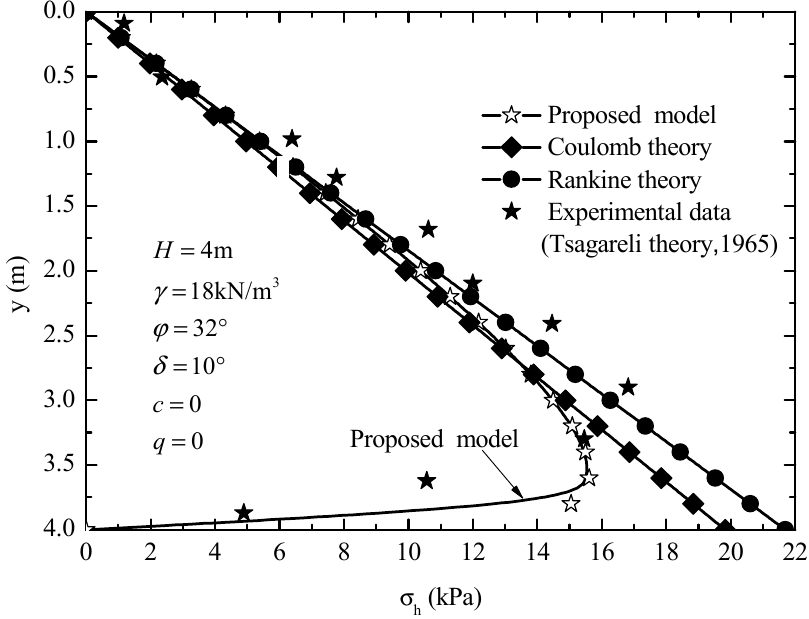
Figure 7. Comparison between the predicted and experimental data ([Rao et al. 2015], with permission from ASCE).